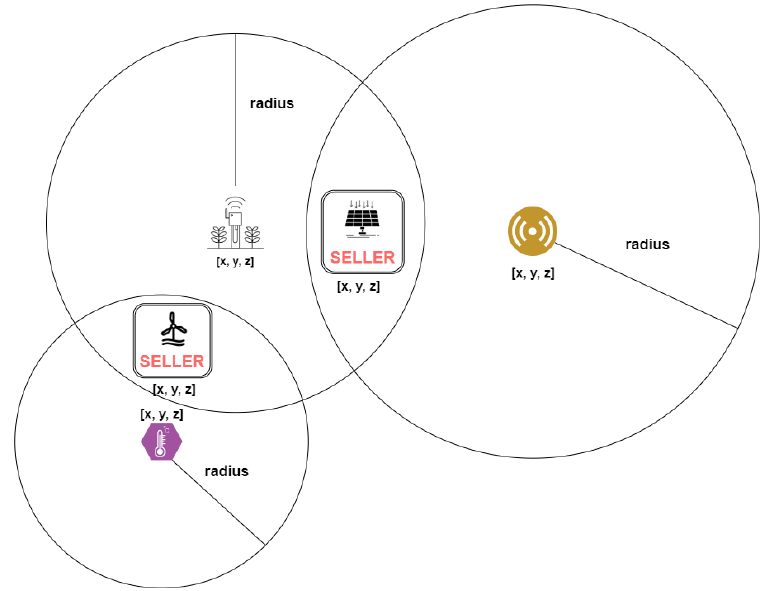
Figure 2. Considered physical